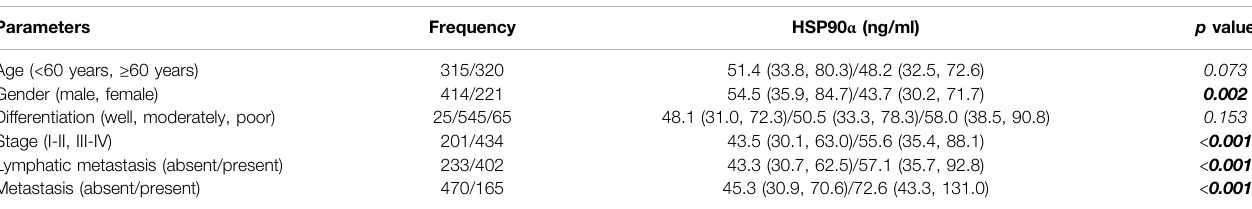
TABLE 2 | Correlations of the plasma HSP90 α with clinicopathologic features in colorectal cancer.